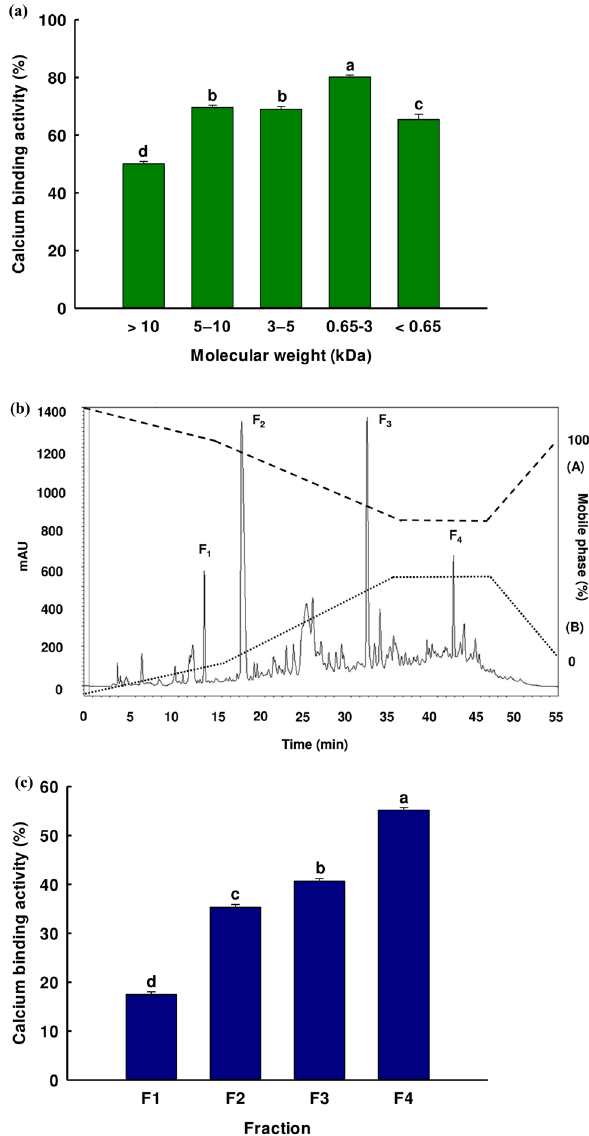
Figure 1. ( a ) Percentage of calcium-binding activity for each of the five fractions of the Alcalase hydrolysate following ultrafiltration; ( b ) Fractions obtained via RP-HPLC and the calcium-binding activity of the MWCO 3–0.65 kDa fraction; ( c ) calcium-binding activity of the four fractions (F 1 , F 2 , F 3 , and F 4 ) separated via RP-HPLC. The values are shown as percentage of calcium-binding activity ± SD, and all testing was carried out in triplicate with a same protein concentration. Where the means is shown using a different letter, this is indicative of a significant difference in Duncan’s multiple range test ( p <